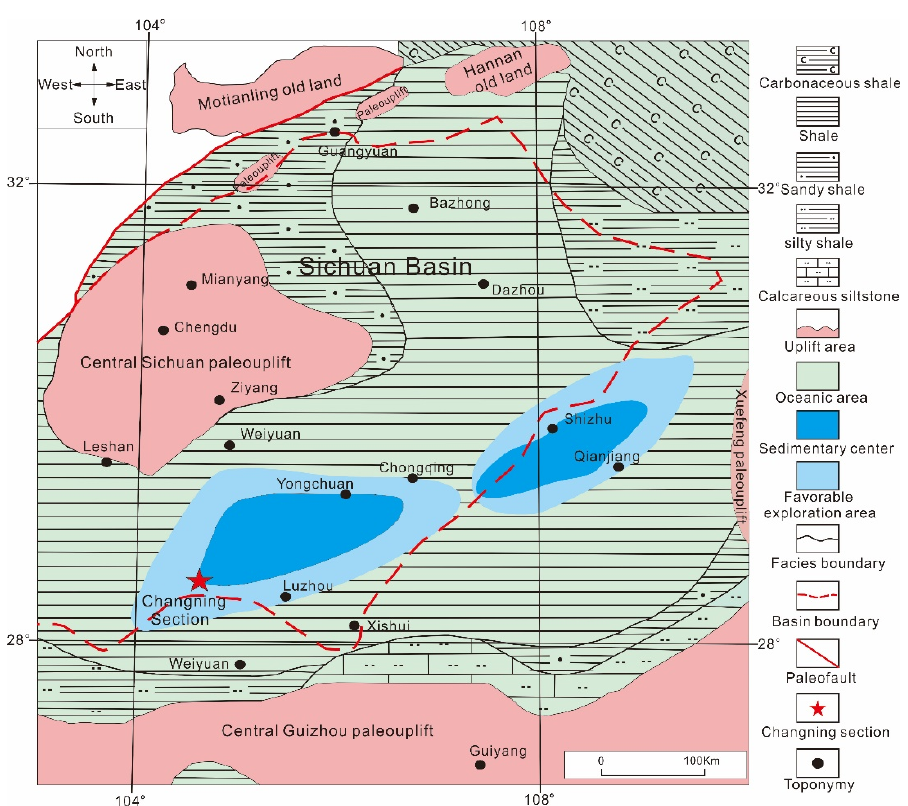
Figure 1. Paleogeographic map of Yangtze platform during the Late Ordovician to Early Silurian period (Modified after [26]).